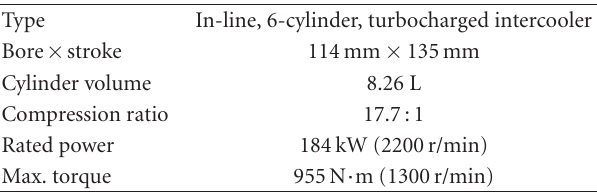
Table 1: Specifications of the test